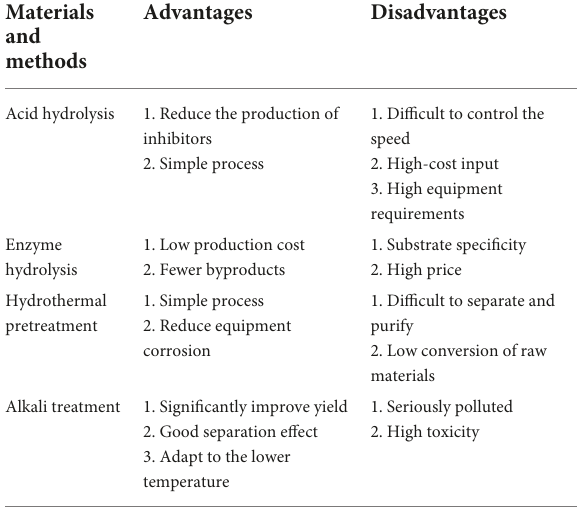
TABLE 1 Comparison of different methods to prepare